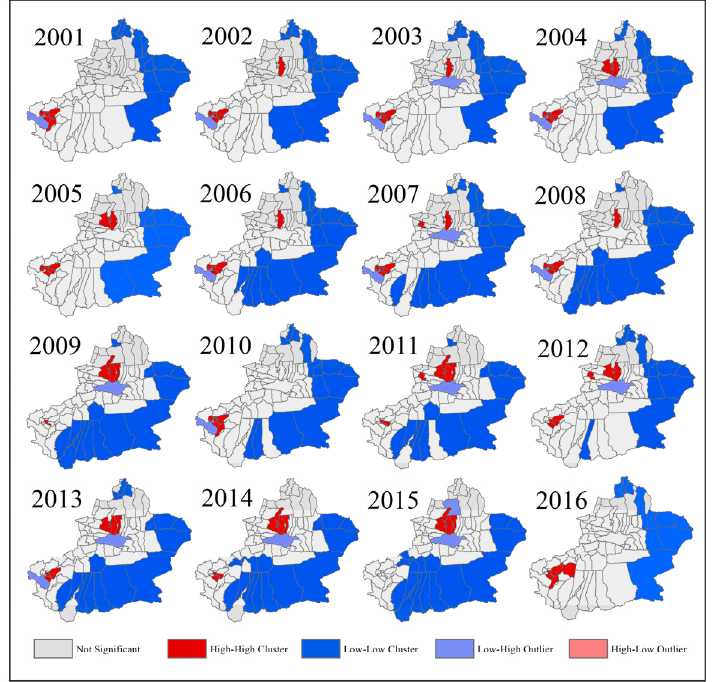
Figure 7. Spatial agglomeration diagram (LISA map) of PM 2.5 concentrations (2001 − 2016).